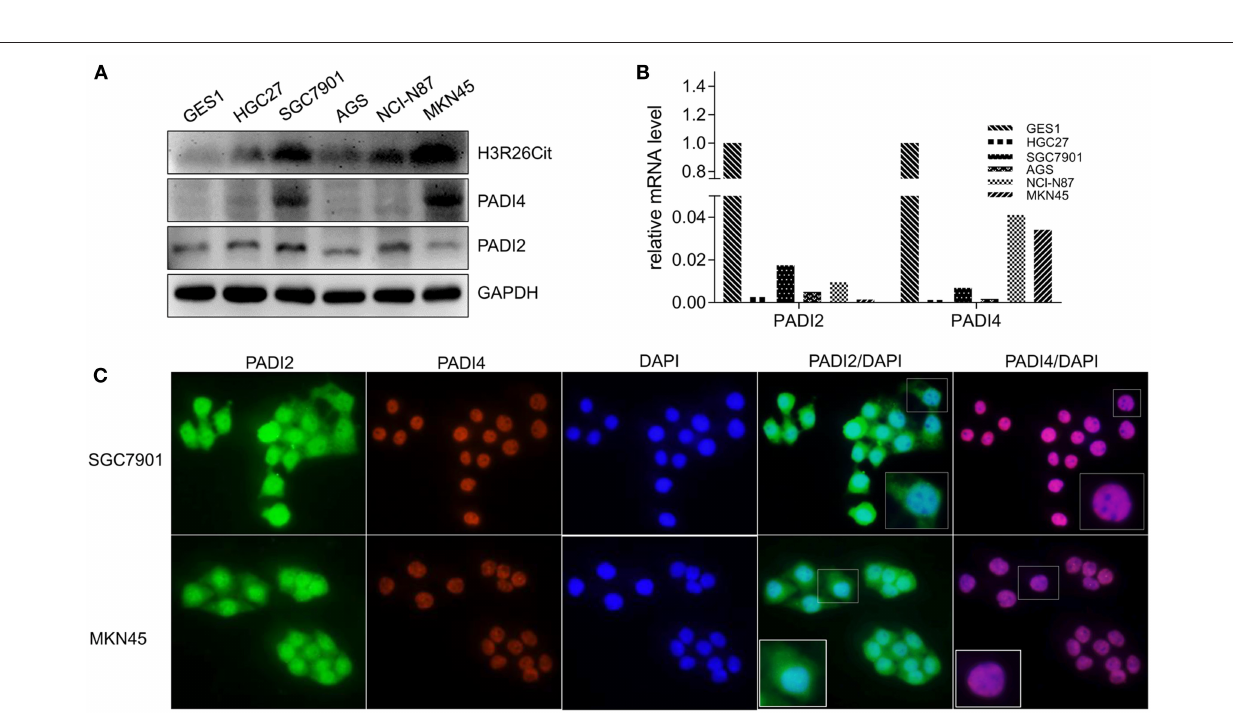
Frontiers in Oncology | www.frontiersin.org